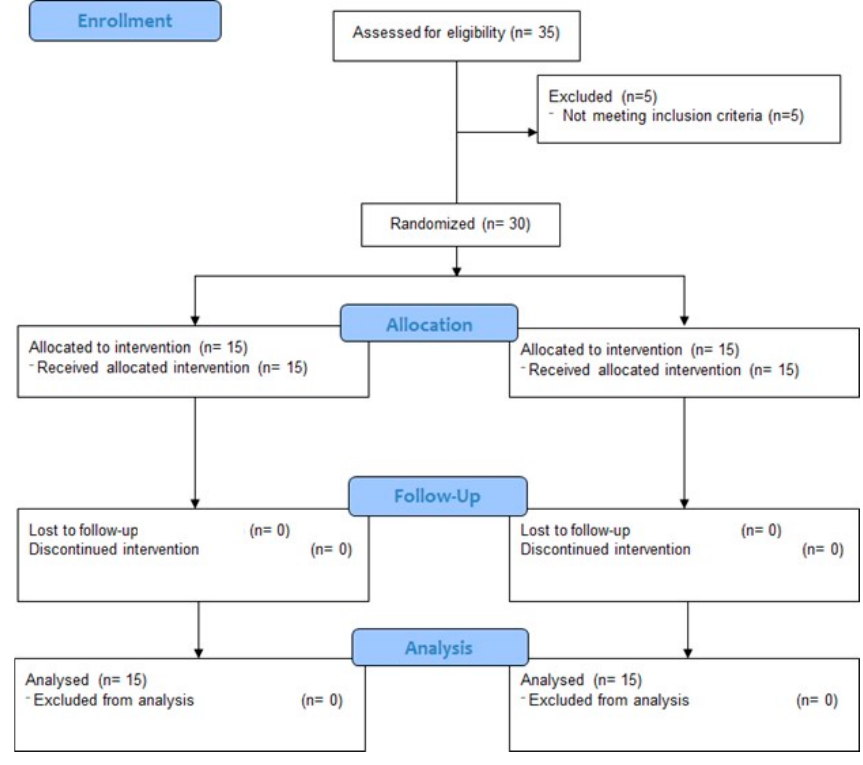
Figure 1. Consort flow diagram outlining the design and conduct of the clinical study.